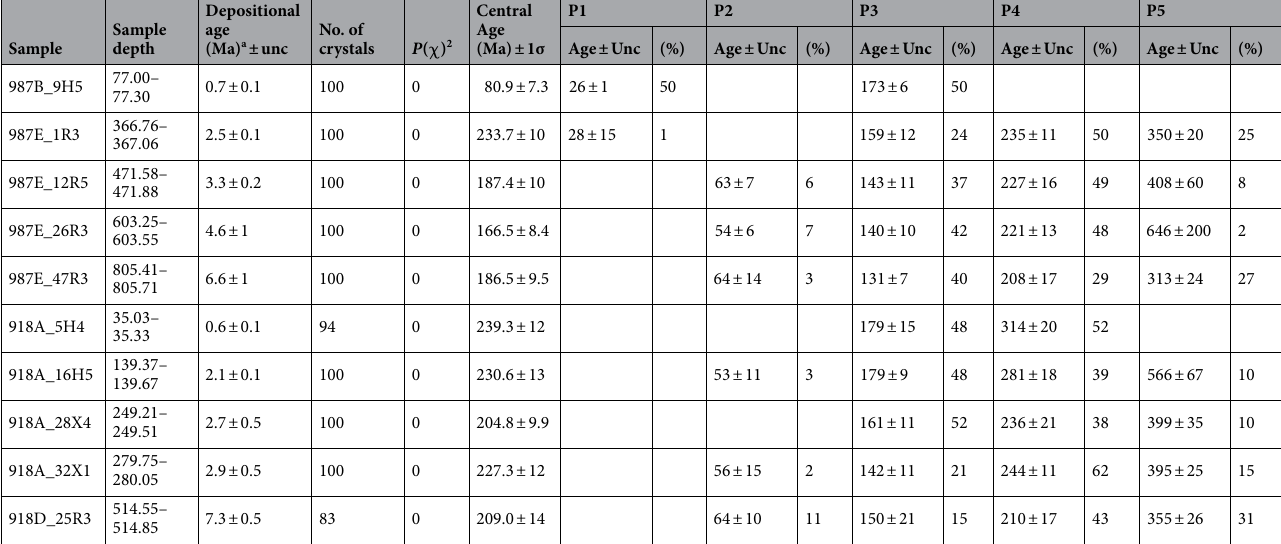
Table 1. Population age. a Depositional age and relative uncertainties are estimated from the age model refined by Bierman et al. 13